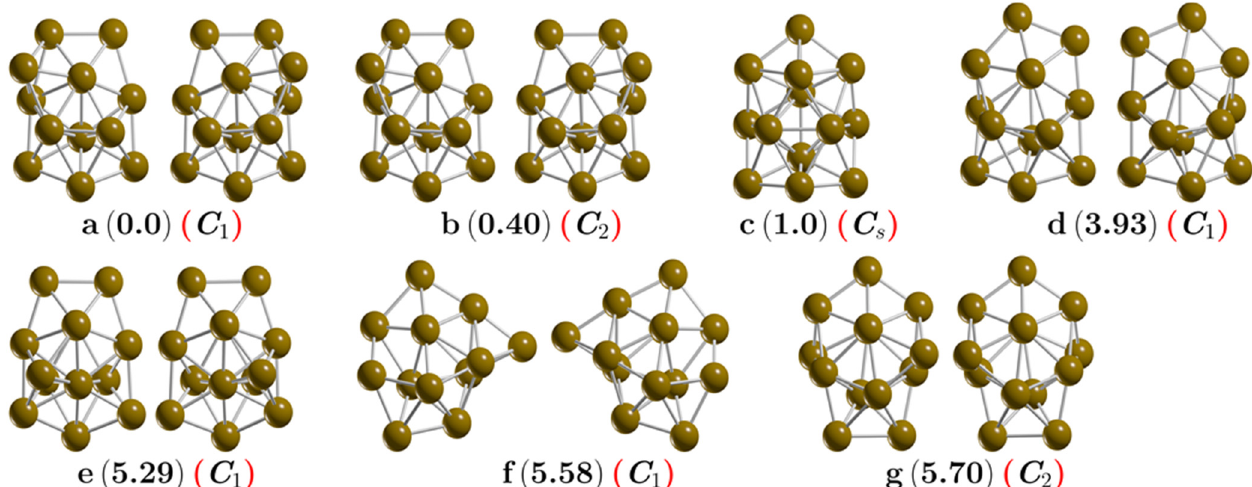
Figure 1. (Color online) The chiral lowest energy structure is depicted in ( a ), the chiral low-energy structures are depicted in ( b , d , e – g ) whereas the achiral structure is depicted in ( c ). Those structures were optimized at the PW91-GD3/def2TZVP level of theory. The first letter indicates the isomer, the relative Gibbs free energies in kcal/mol appear in round parentheses computed at 298.15 K, and the point group symmetry in red round parentheses. The isomers, represented in ( a , b ), differ only in molecular symmetry. The isomer with C 2 symmetry has a Gibbs free energy equal to RTln σ less than the non-symmetric C 1 isomer. The RMSD between the isomer with symmetry C 1 and the isomer with symmetry C 2 is 0.0014. All atomic XYZ coordinates are given in Supplementary materials.